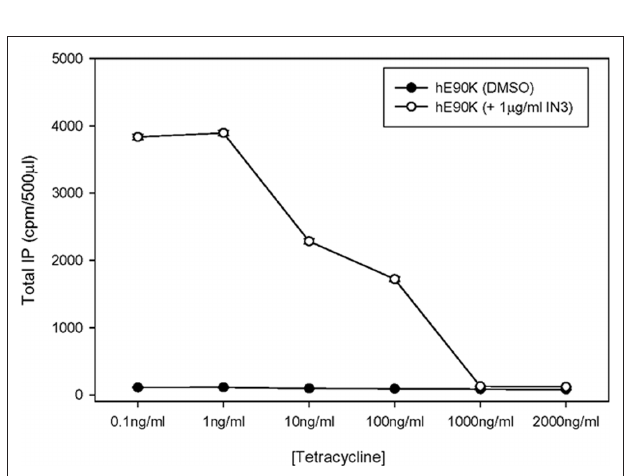
FiGurE 2 | Loss of iP production (in the presence of tetracycline) in stably transfected cells with or without in3 treatment shows that expression of the (rescued) mutant protein is under control of this